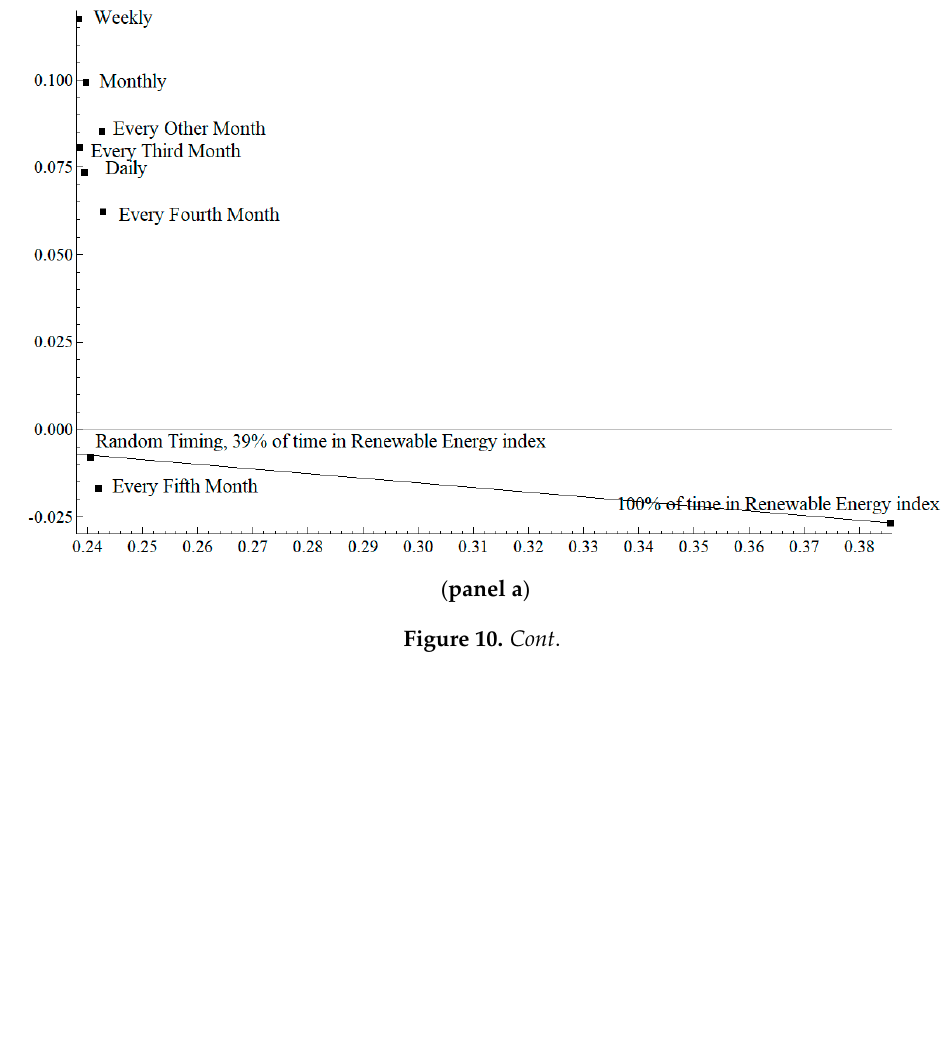
Figure 9. Daily prices in Stoxx600 Europe Renewable Energy Index before dividends in Euro/index share, 2 December 2008 to 28 September 2018.